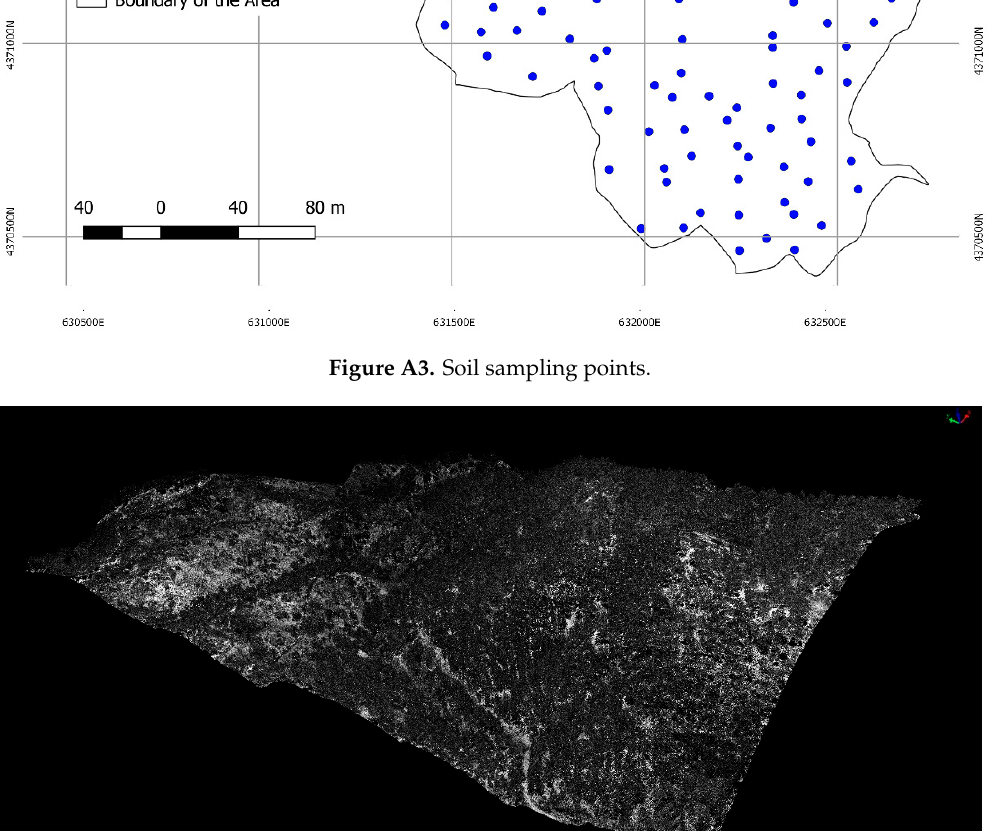
Figure S4. Point cloud of the study area.